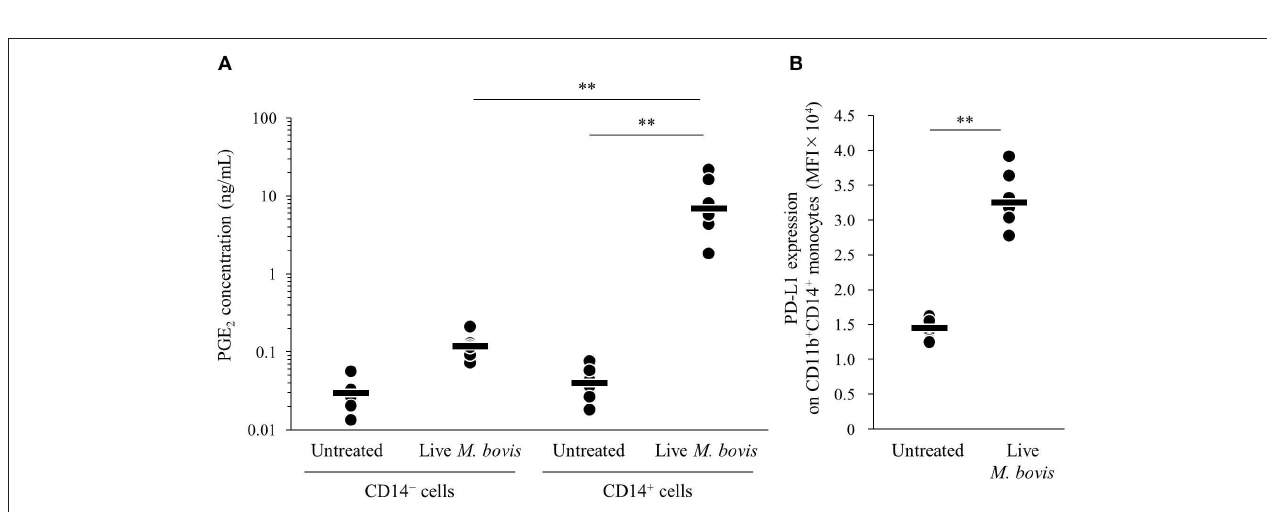
FIGURE 1 | cultured in 24-h culture supernatant of PBMCs with or without live M. bovis (untreated: n = 9, MOI 0.1: n = 9, MOI 1: n = 9, MOI 10: n = 9) were analyzed by flow cytometry. (H) PBMCs from uninfected cattle were incubated with PGE 2 , and PD-L1 expression on CD11b + CD14 + monocytes (DMSO: n = 6, PGE 2 : n = 6) was determined using flow cytometry. The bars are the median of the values (A,B,D,E,G,H) . Statistical significance was determined by the Steel–Dwass test (A,B,G) or Mann–Whitney U -test (D,E,H) . Correlation statistics were analyzed using Spearman’s correlation analysis (C,F) . * P < 0.05.